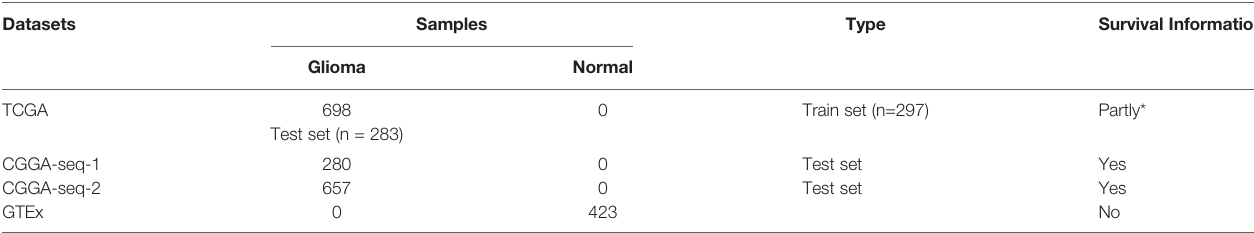
TABLE 2 | Information on multiple